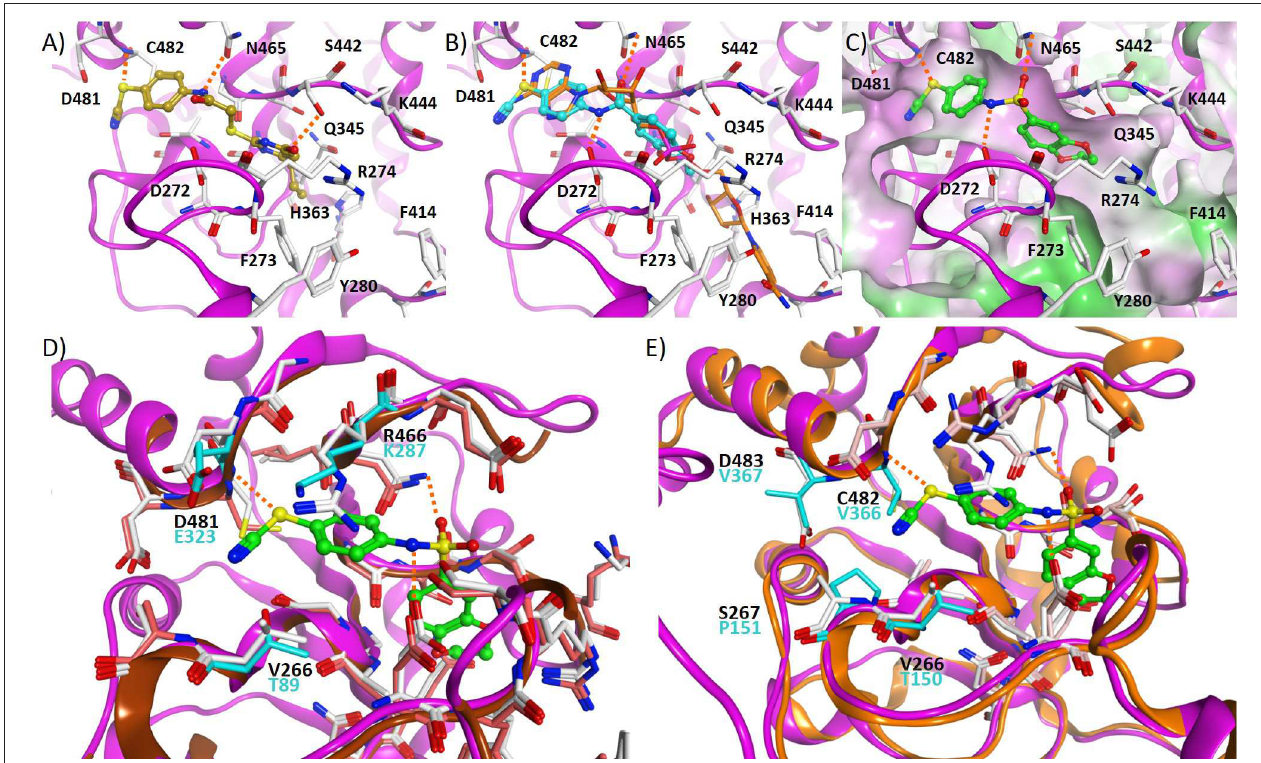
FIGURE 2 | Sirt1 ribbon is colored purple, hydrogen bonds are shown as dashed lines. (A) Docking pose obtained for S1th 1 (colored beige) at the Sirt1 NAD + binding pocket. (B) Docking pose obtained for S1th 7 (colored cyan) at the Sirt1 NAD + binding pocket, NAD + (colored orange) is shown for comparison. (C) Docking pose obtained for S1th 13 (colored green) at the Sirt1 NAD + binding pocket. The molecular surface of the binding pocket is colored according to the hydrophobicity (hydrophobic = green, hydrophilic = magenta). (D) Superimposition of the crystal structure of Sirt1 (PDB ID 4I5I, magenta colored ribbon, white colored residues) with docked S1th 13 (colored green) and the crystal structure of Sirt2 (PDB ID 5D7Q, brown colored ribbon, pink colored residues). The amino acid residues of Sirt2 that are different are colored cyan. (E) Superimposition of the crystal structure of Sirt1 (PDB ID 4I5I, magenta colored ribbon, white colored residues) with docked S1th 13 (colored green) and the crystal structure of Sirt3 (PDB ID 4BV3, orange colored ribbon, salmon colored residues). The amino acid residues of Sirt3 that are different are colored cyan.